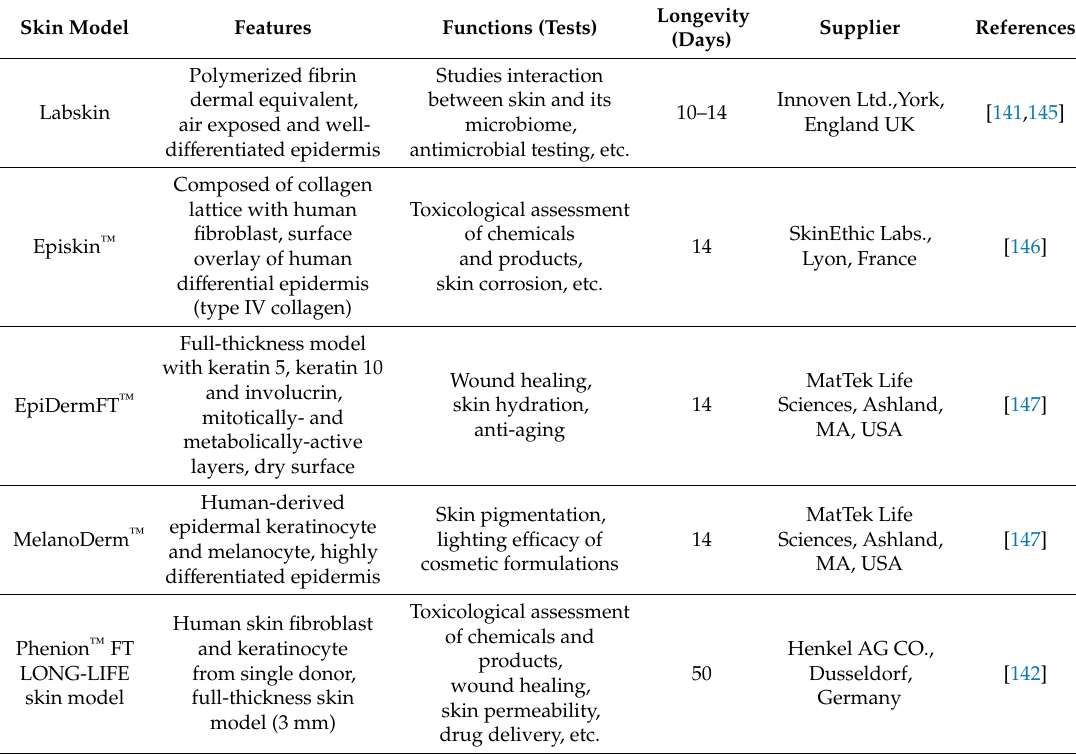
Table 1. Commercially available 3D in vitro skin